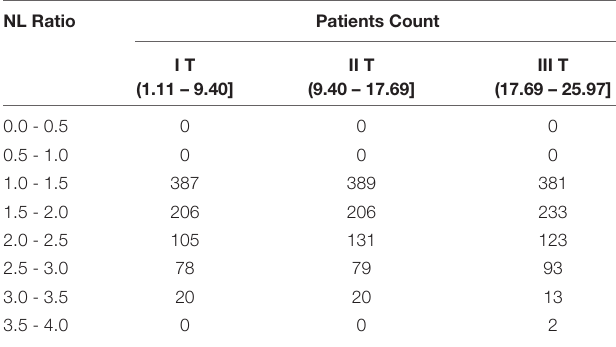
TABLE 4 | Quantities of patients divided according to the Vitamin D levels in terms of NL